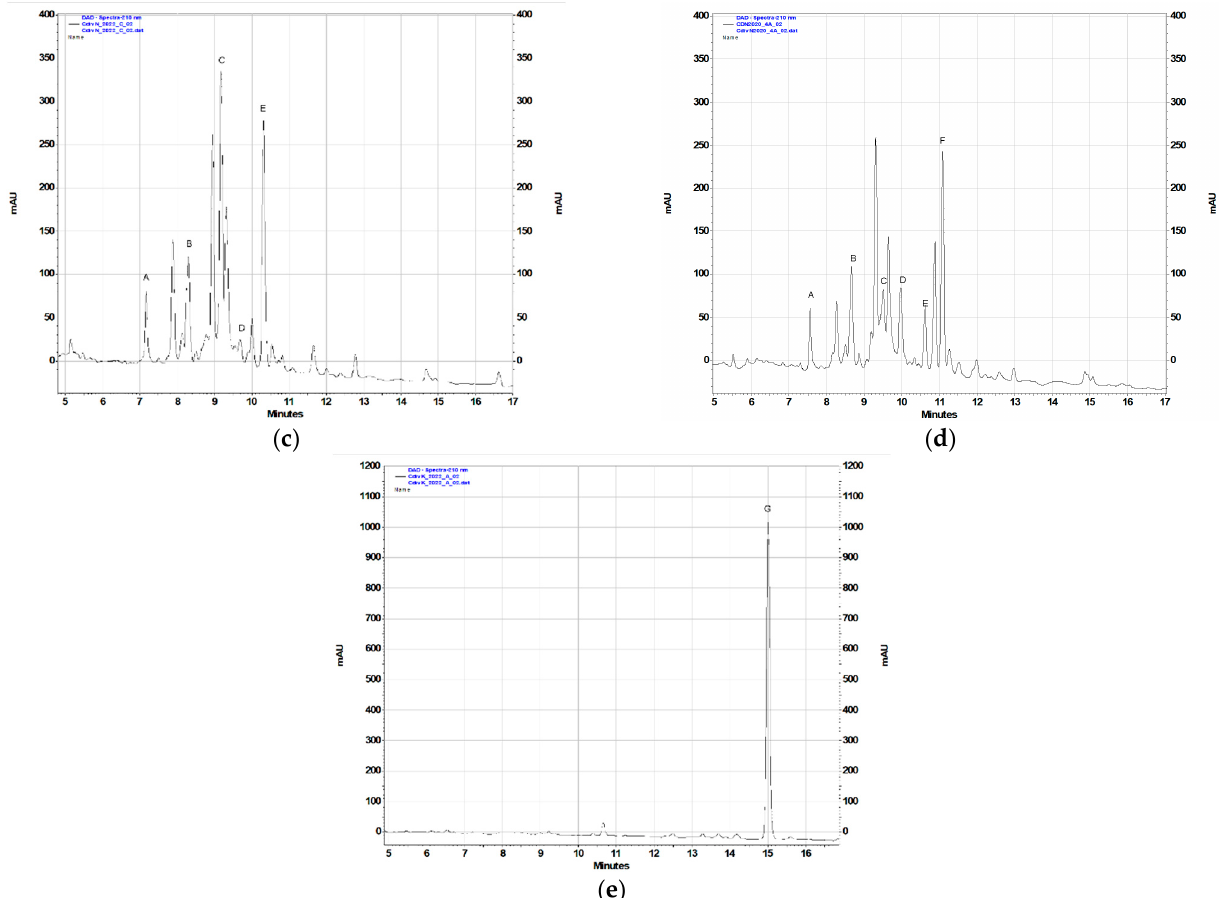
Figure 2. Chromatographic separation (RP-HPLC-DAD; λ = 205 nm) of C. divaricatum extracts (100 mg/mL): ( a ) plants from a liquid MS medium containing TDZ; ( b ) plants grown on a solidified MS medium supplemented with 2.0 μ M BA and 0.1 μ M NAA; ( c ) leaves of field-grown plants collected in 2022; ( d ) leaves of the plants collected in 2020; ( e ) roots of a field-grown plant collected in